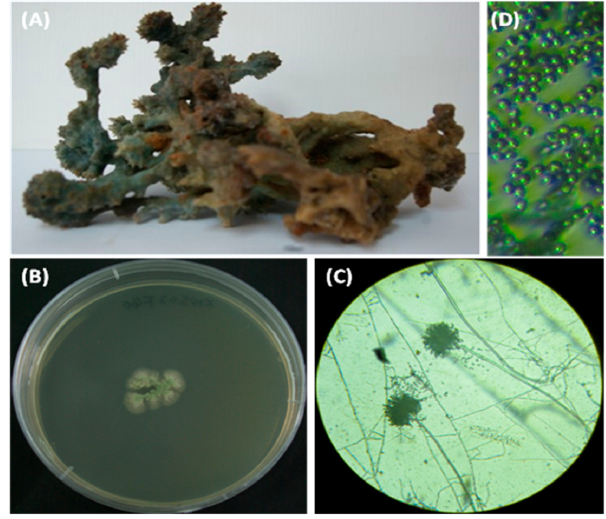
Figure 5. Colony appearance and micromorphology of Aspergillus sp. SCSIO XWS02F40 and the sample of the sponge Callyspongia sp. ( A ) sample of the sponge Callyspongia sp.; ( B ) colony appearance after seven days at 25 ˝ C (MB medium); ( C ) conidiophores after seven days at 25 ˝ C under a light microscope; ( D ) conidia as seen using a light